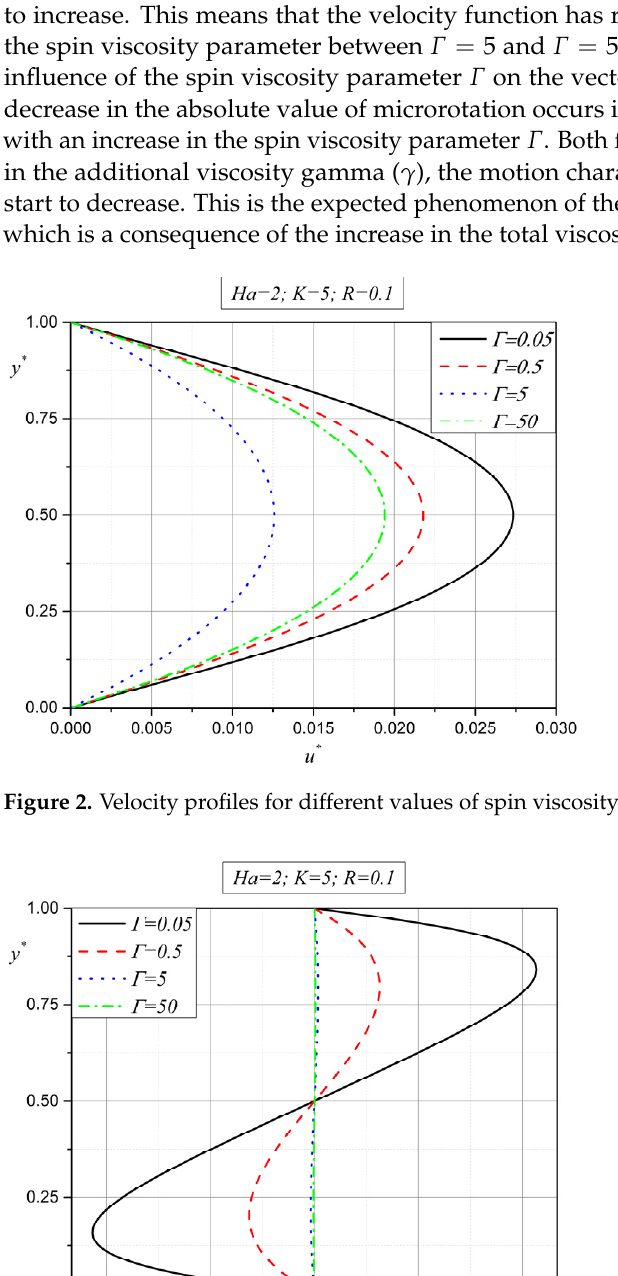
Figure 4. Influence of spin viscosity parameter 𝛤 on dimensionless temperature 𝜃 . Together with the additional viscosity gamma ( 𝛾 ), one more viscosity is taken into consideration when micropolar fluids are investigated. The influence of the additional viscosity lambda ( 𝜆 ) is presented through the coupling parameter 𝐾 . The next three fig ‐ ures show the velocity, microrotation and temperature dependency on the coupling pa ‐ rameter 𝐾 . From Figures 5 and 6, it is obvious that the additional viscosity lambda emphasizes the characteristics of micropolar fluids [39]. The vector of microrotation, defined with an ‐ gular impulse Equation (13), is the landmark of micropolar fluids. Because of this, from Figure 6, it can be noted that an increase in the coupling parameter 𝐾 leads to an increase in the absolute value of microrotation. Figure 5 shows that the velocity decreases with an increase in the coupling parameter 𝐾 . This means that the additional viscosity lambda ( 𝜆 ) emphasizes the microrotation vector of small particles embedded in the fluid.